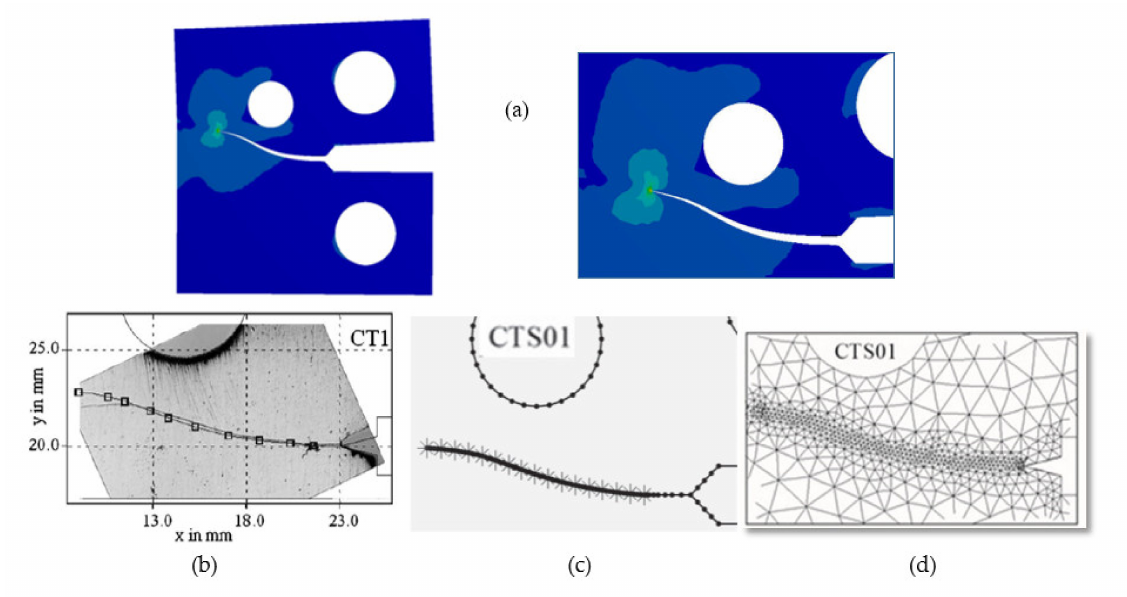
Figure 6. The predicted crack path of CTS01 ( a ) present study, ( b ) experimental and numerical results of [24], ( c ) BemCracker2D [41] and ( d ) Quebra2D [41].